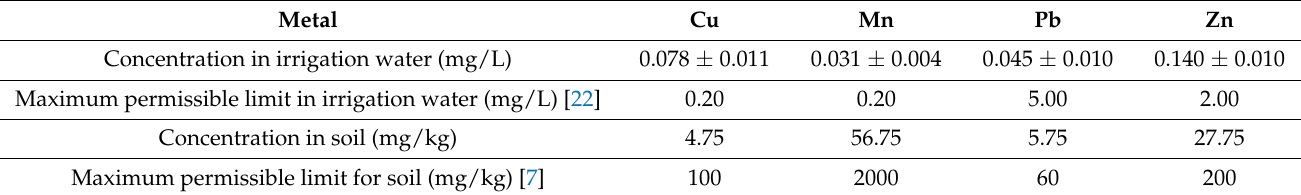
Table 3. Initial HM concentrations in the agricultural soil (mg/kg), and average concentration in irrigation water (mean ± standard deviation; mg/L) during the growing